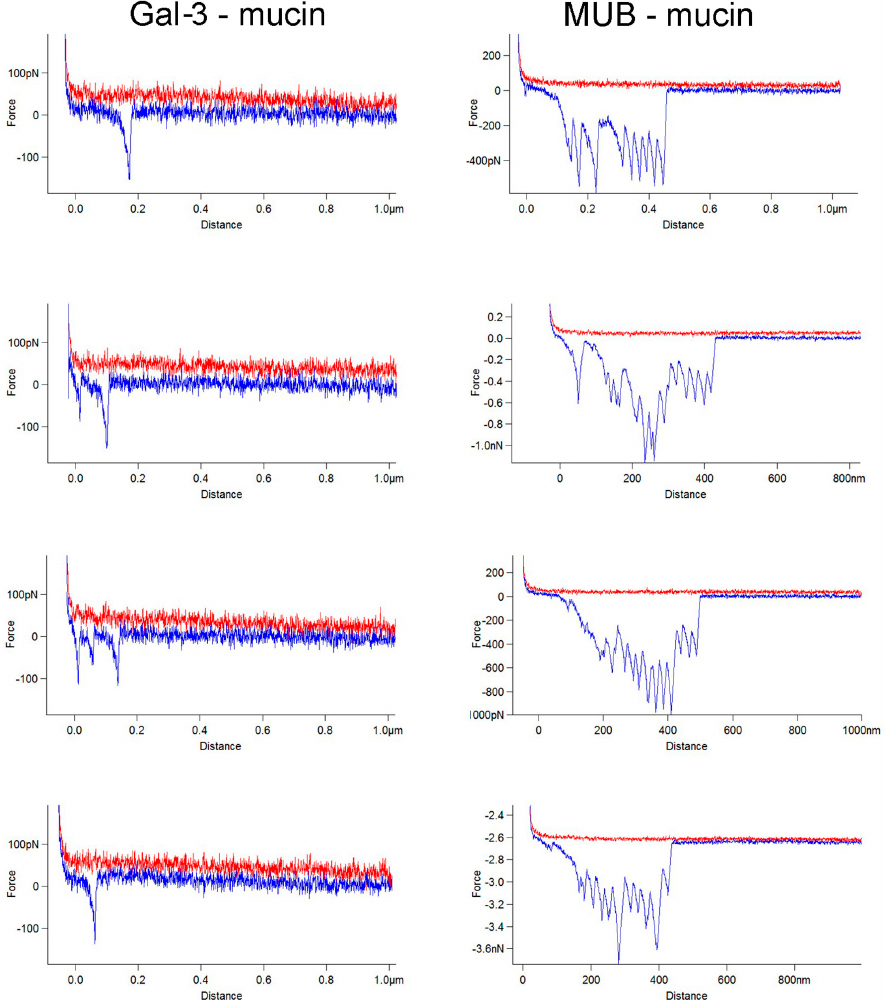
Figure 7. Comparison of force curves of the interactions between ( left ) Gal-3 and mucin and ( right ) MUB and mucin. These illustrate the differences between the molecular unfolding events of MUB and occasional, but non-symmetrical, multiple adhesive events of Gal-3 in each of their retraction force-distance curves as they interact with mucin.